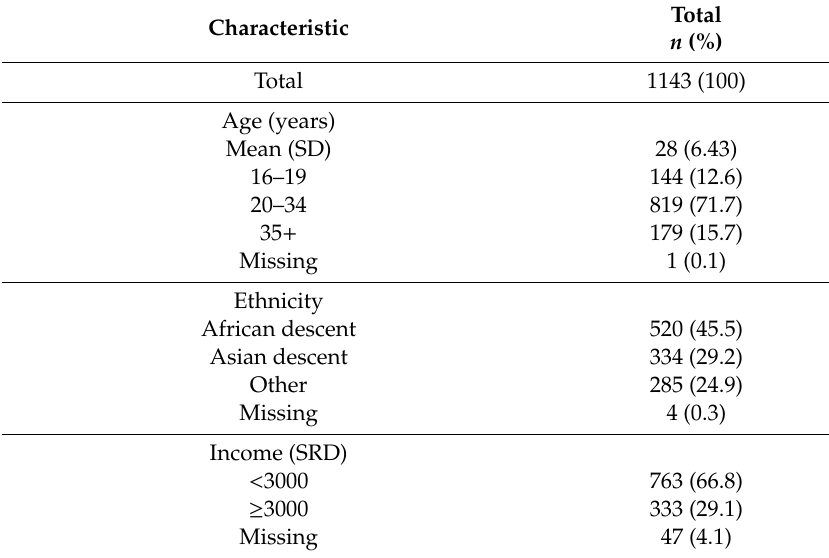
Table 1. Demographic characteristics of the study